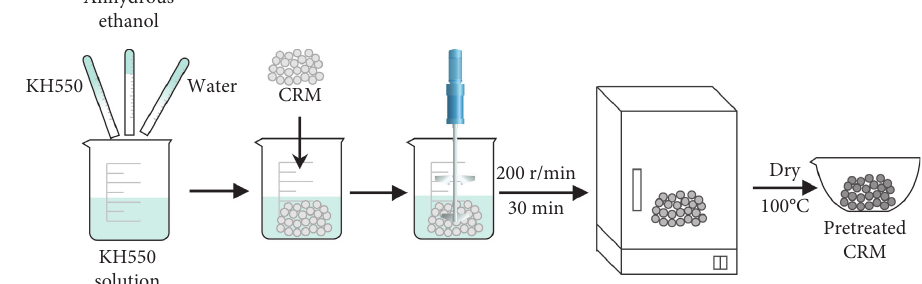
Figure 1: The process flow for pretreating CRM with KH550 solution.